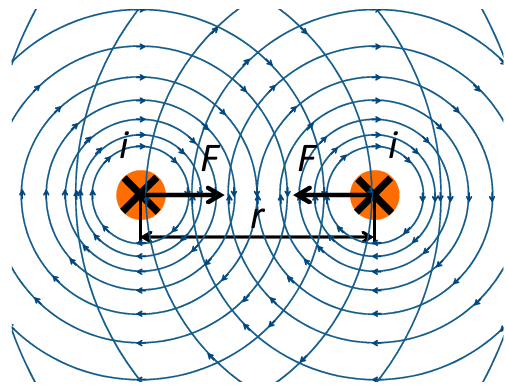
Figure 4. Interaction of wires conducting a current.